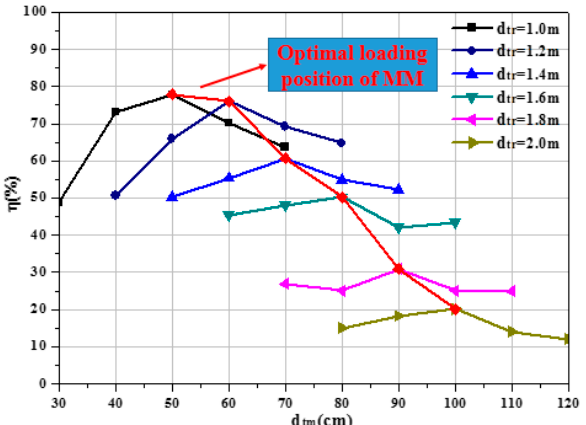
Figure 13. Effect of the MMs’ loading position on the system transmission efficiency.